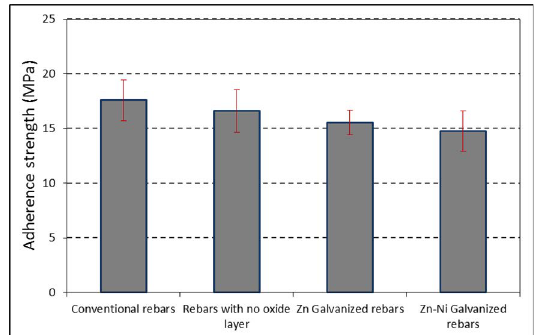
Figure 10. Pull out test resistance of rebars with different surface conditions. Analyzing the flexural behaviour of reinforced concrete beams, Hamad and Mike 37 identified a slight reduction in the tensile strength of beams with a galvanized bar compared to beams with black rebar due to a reduction in bond strength (4 to 6%) due to galvanizing. Hamad and Jumaa 38 suggest that a negative effect on the bond between the galvanized bar and the surrounding concrete can be associated to three factors: reduction in chemical adhesion and friction; passivation of galvanized bar due to the reaction which takes place between the zinc and the wet cement paste; the retarding effect of the corrosion products of the reaction of zinc with the wet cement paste on cement hydration. Kayali and Yeomans 24 compared the bond and slip behaviour of deformed (i.e. ribbed) galvanized and black steel rebars in concrete. These authors showed that the critical load verified for galvanized rebars was not statistically different to that verified for black steel. According to Pokorný et al 39 the shear stress necessary to completely pull-out the hot-dip galvanized ribbed rebar from concrete is similar to that for black steel. However, the bond stress, for rebar displacement equal to 0.001 mm, is smaller for electroplated rebars in comparison to conventional rebars without treatment, indicating a reduction in the adhesion bond with